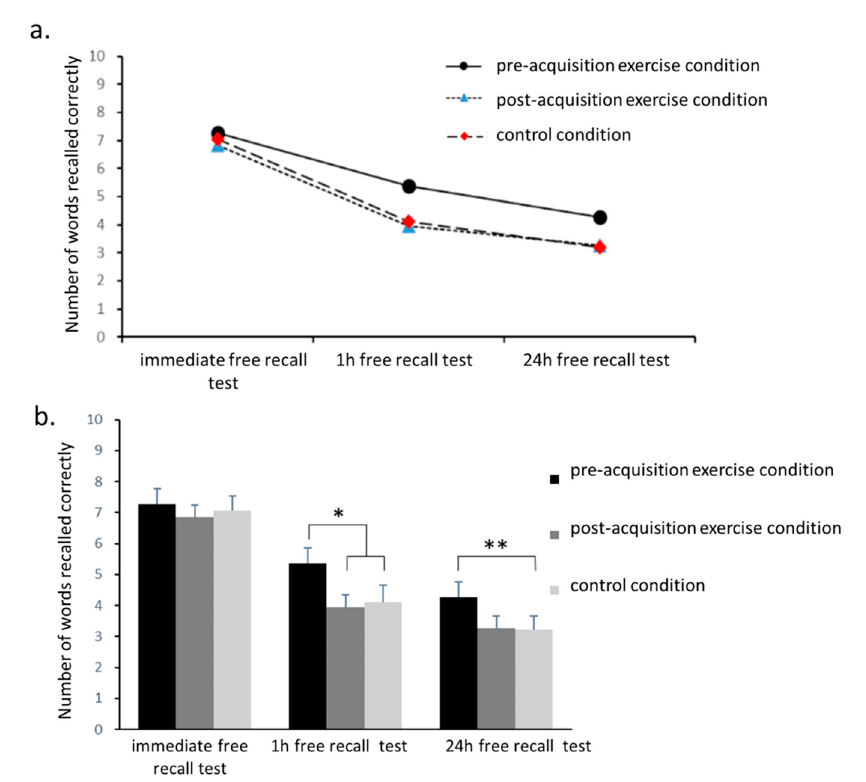
Figure 4. Comparisons of the number of words recalled correctly in the PM experiment. ( a ) Comparisons over time. ( b ) Comparisons between conditions. * p < 0.05, ** p < 0.01.